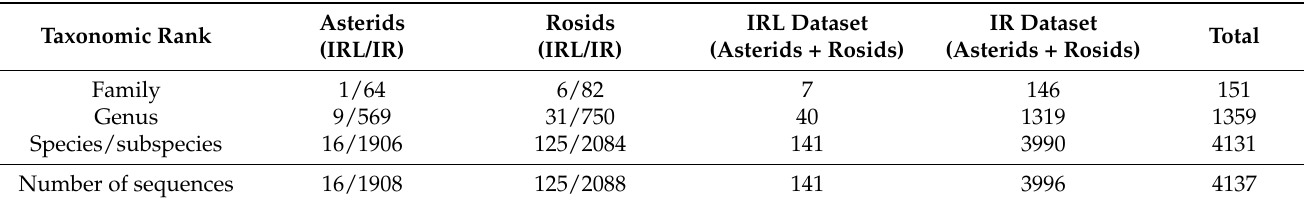
Table 8. Complete chloroplast sequences used in the analysis.